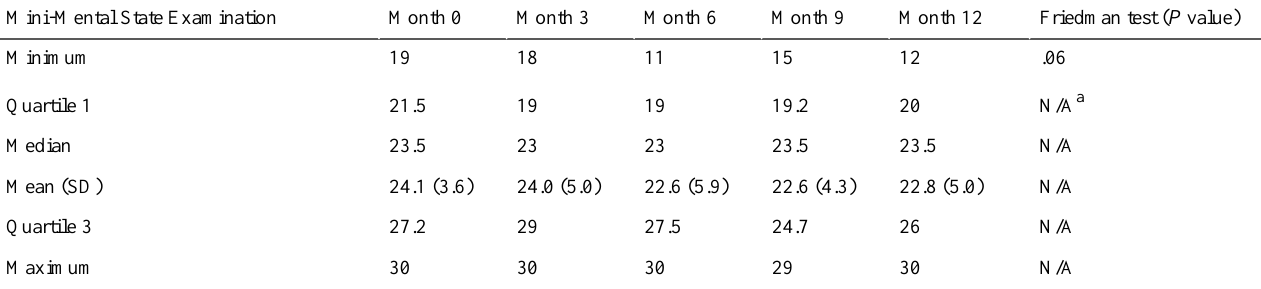
Table 6. People with dementia Mini-Mental State Examination score during the year progression.